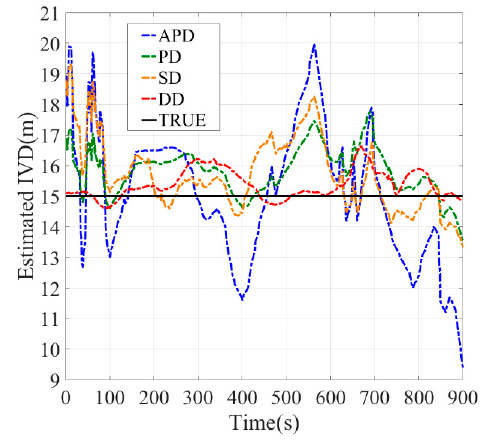
Figure 12. Baseline = 15 m.